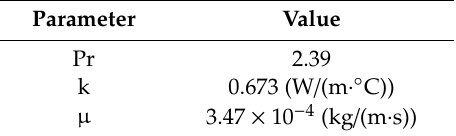
Table 3. Water flow properties.